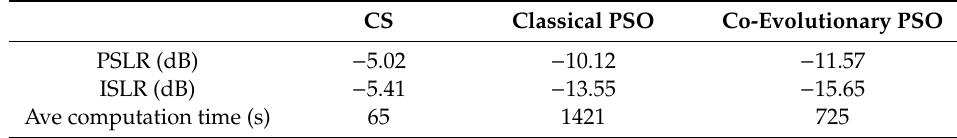
Table 2. Comparison of the algorithms.